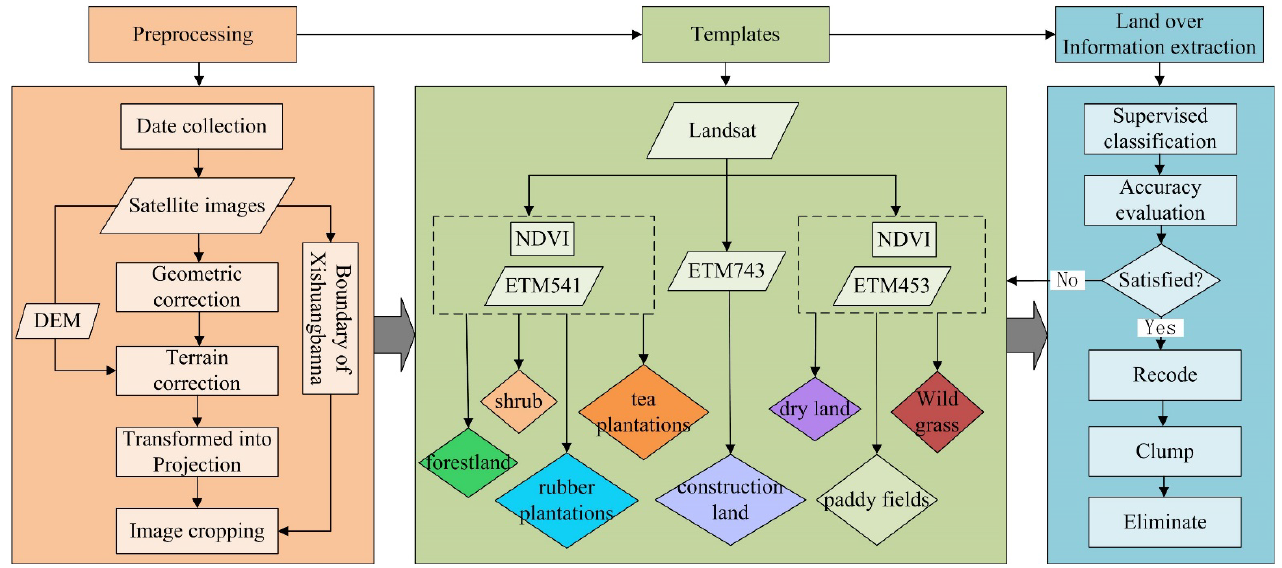
Figure 1. Image processing procedure.